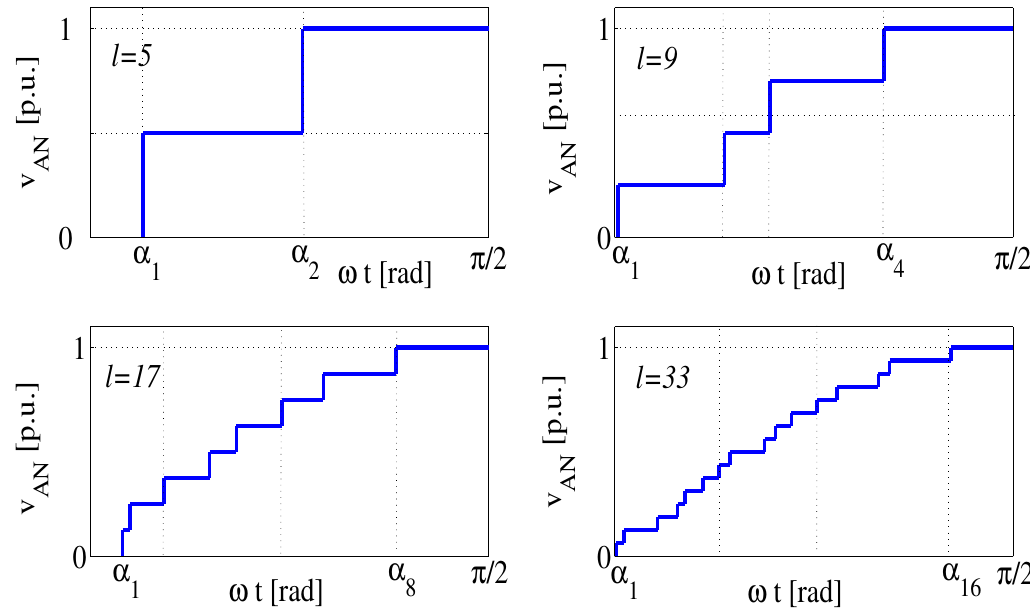
Figure 9. Output voltages for 5-level, 9-level, 17-level and 33-level